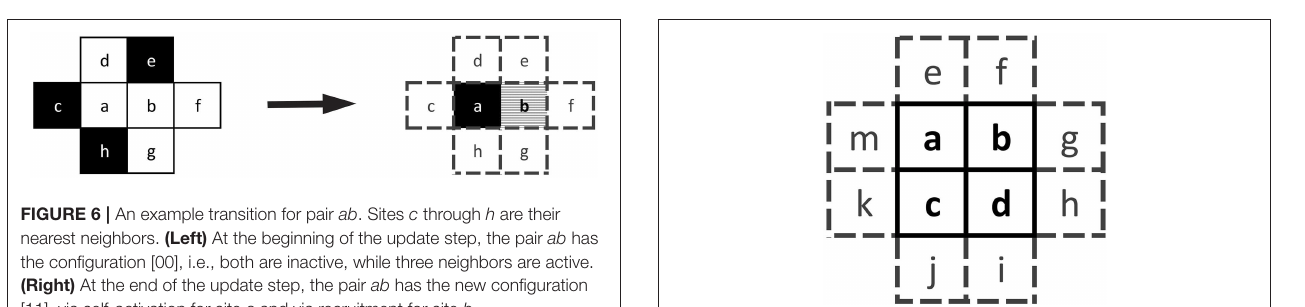
FIGURE 7 | Template for the 2 × 2 quartet abcd and its eight nearest neighbors e through m . Each letter can take on the value 0 or 1.